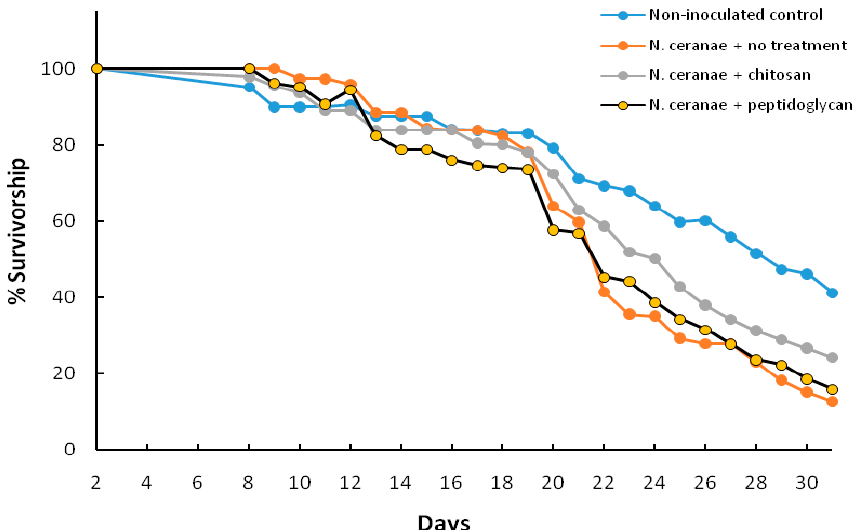
Figure 1. Percentage of bees that survived during 31 days in observation hives after the bees were inoculated with 1 × 10 5 spores of N. ceranae only ( N. ceranae + no treatment), inoculated with N. ceranae and 1.0 µ g / µ L of chitosan ( N. ceranae + chitosan), N. ceranae and 1.0 µ g / µ L of peptidoglycan ( N. ceranae + peptidoglycan) or not inoculated or treated (Non-inoculated control) (n = 500 per treatment).